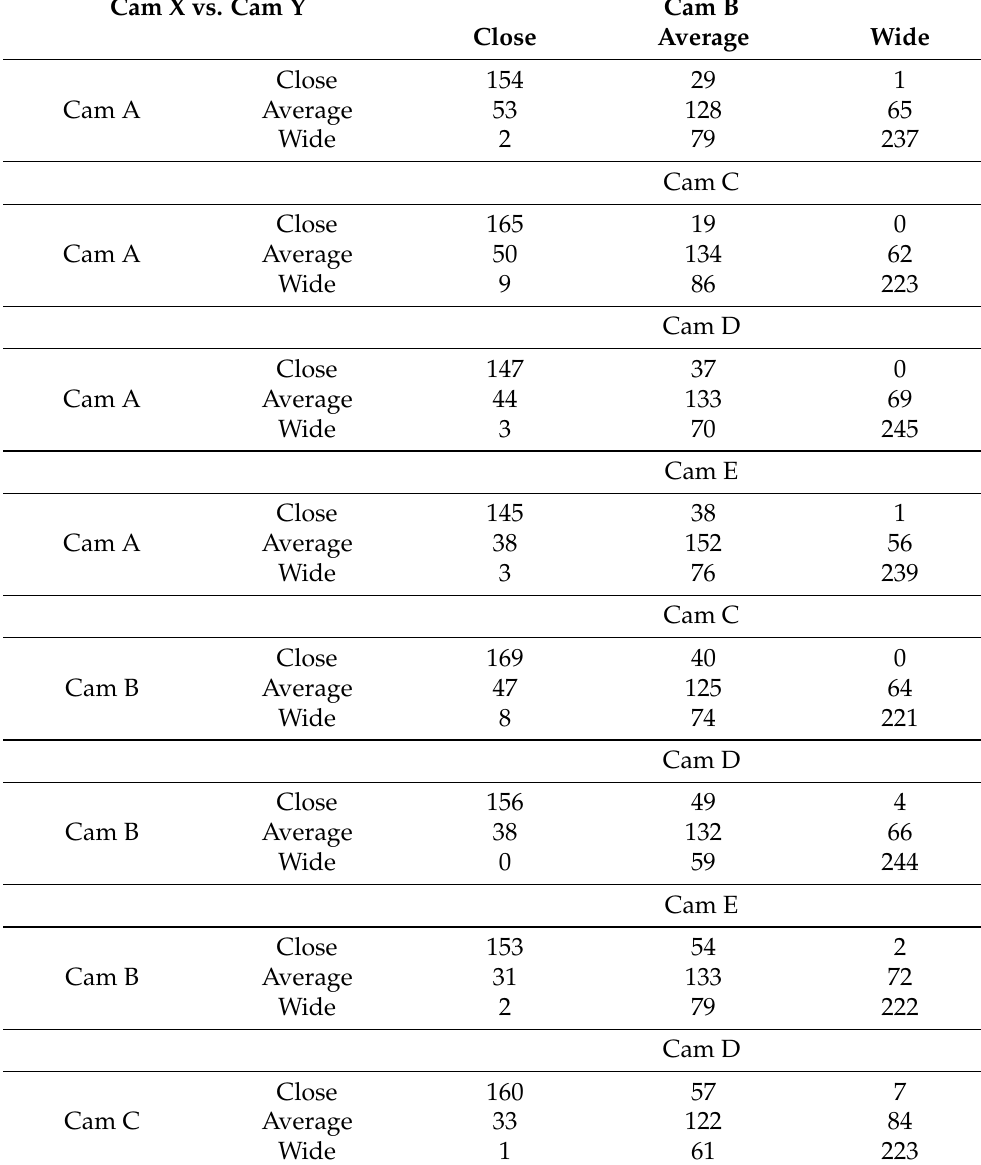
Table A2. Confusion matrices depict eye setting attributes prediction in each individual camera versus another